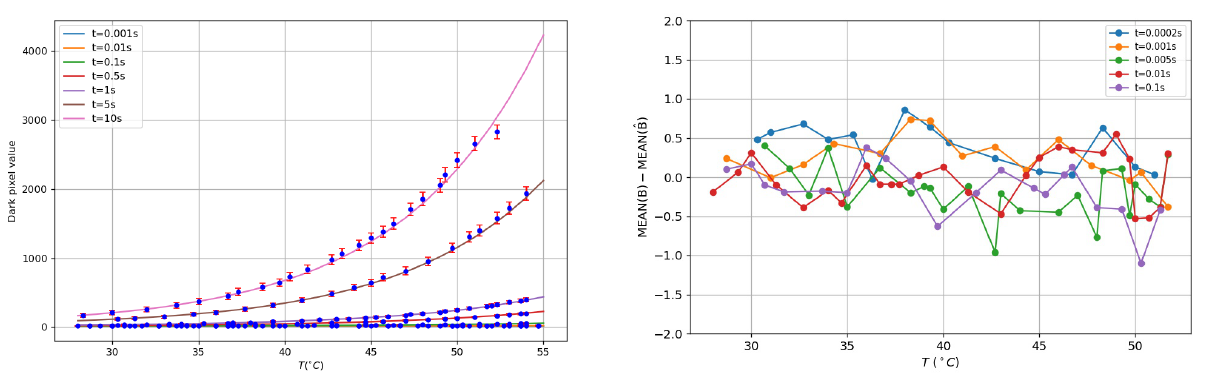
Figure 5. The mean value (blue point) and the standard deviation (red bar) of dark images as a function of the sensor temperature at different exposure times.